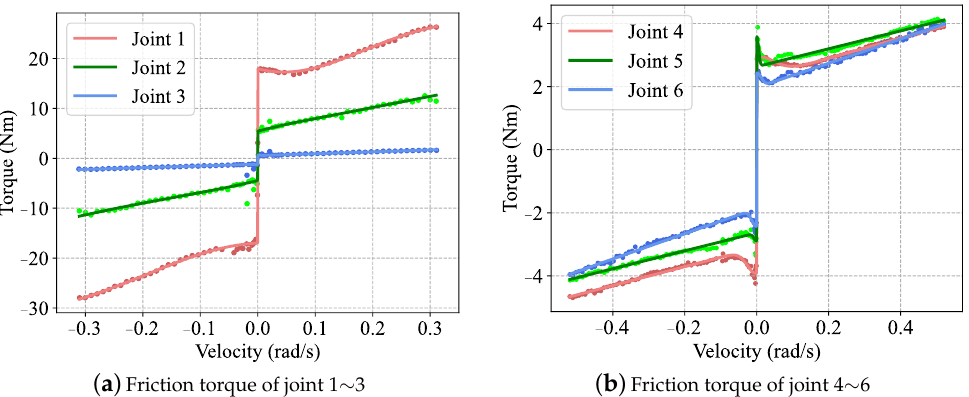
Figure 6. The relationship between friction torque and joint velocity. The dots represent the measured data, and the solid lines indicate the identified